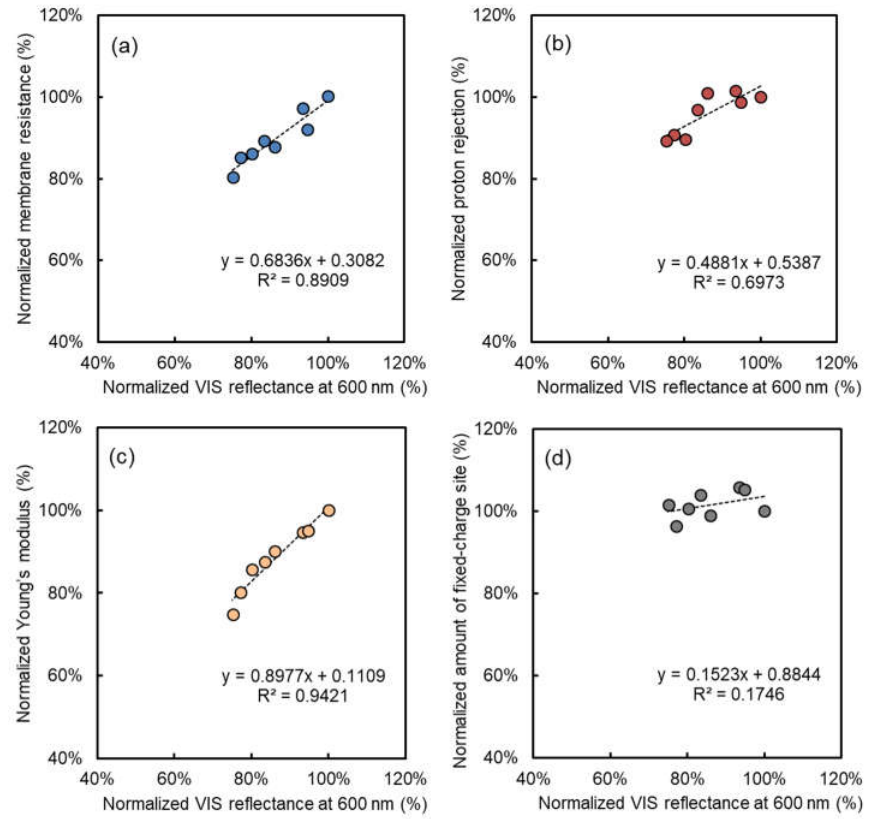
Figure 4. Relationships between electrical and mechanical properties and normalized relative total VIS reflectance at 600 nm of AMX after immersion tests into NaOH solution at 40 °C: normalized ( a ) electrical resistance, ( b ) proton rejection, ( c ) Young’s modulus, and ( d ) amount of fixed-charge sites.